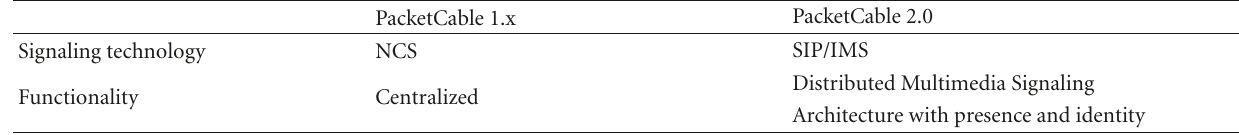
Table 1: Analysis of PacketCable 2.0 architectural evolution over PacketCable